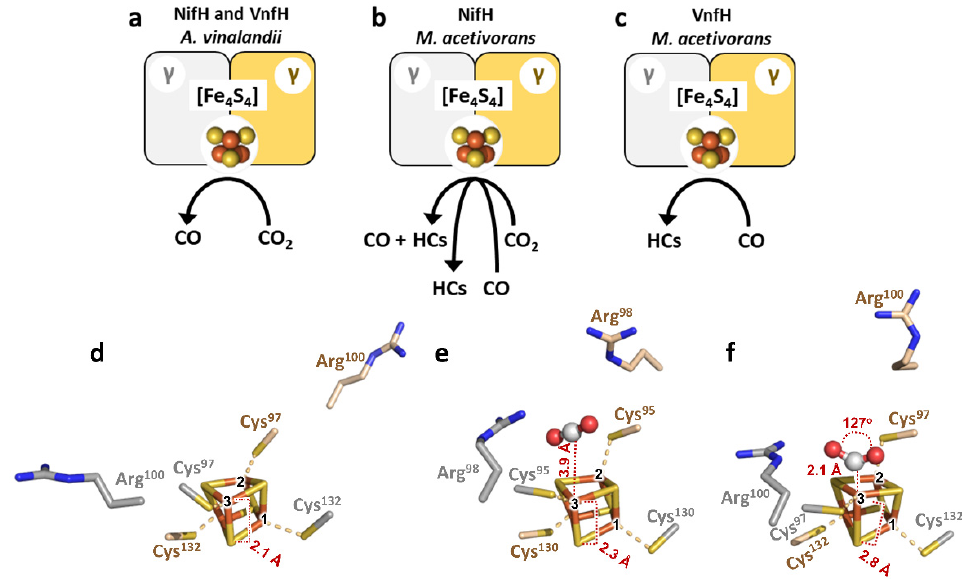
Figure 10. Differential reactivities of the Fe proteins with C 1 substrates. ( a – c ) Schematic presentations showing the abilities of ( a ) the A. vinelandii NifH and VnfH proteins to reduce CO 2 to CO; ( b ) the M. acetivorans NifH protein to reduce CO 2 to CO and hydrocarbons (HCs), and CO to hydrocarbons (HCs); and ( c ) the M. acetivorans VnfH protein to reduce CO to hydrocarbons (HCs). ( d – f ) Crystal structures of ( d ) the reduced Av NifH (PDB entry 2nip) that is free of substrate and ( e ) the reduced Ma NifH with CO 2 bound in an unactivated, linear conformation (PDB entry 6nzj); and ( f ) DFT-optimized structure of the super-reduced Av NifH (PDB entry 6o0b) with CO 2 bound in an activated, bent conformation.